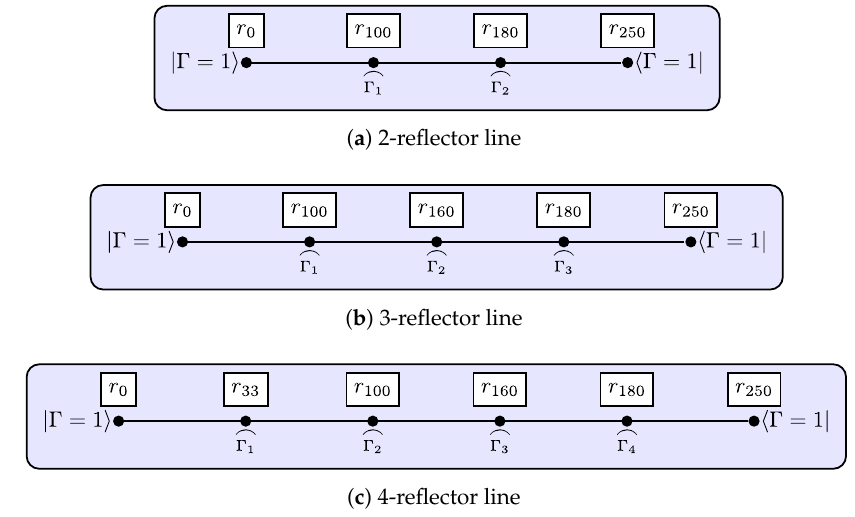
Figure 4. Single Line Networks. For the 2-reflector line ( a ), reflectors are at positions 100 and 180, corresponding to 300 m and 540 m from the start node, respectively.